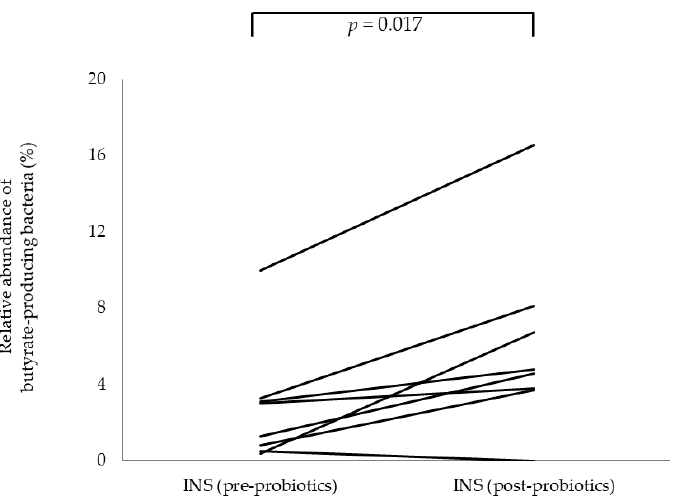
Figure 3. Changes in the composition of butyrate-producing bacteria in children with idiopathic nephrotic syndrome (INS) before and after Clostridium butyricum MIYAIRI administration. Analy- sis before and after probiotic treatment revealed a significant increase in the relative abundance of butyrate-producing bacteria at the species level.